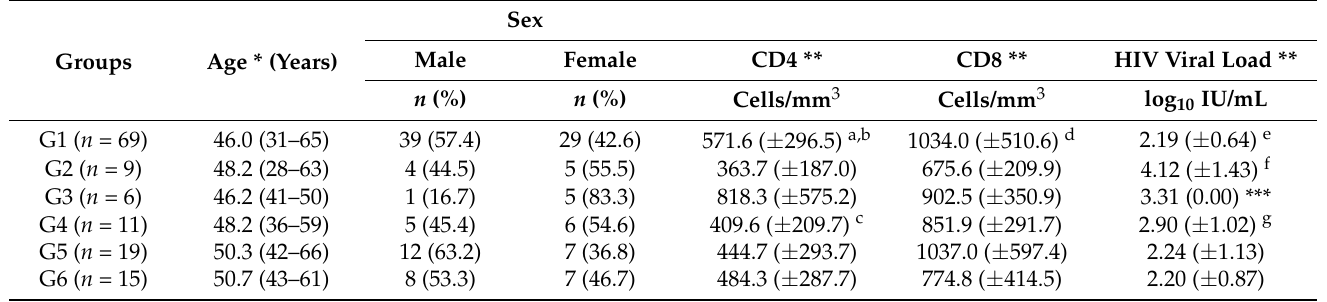
Table 1. Demographic characteristics, CD4 and CD8 T-cells counts, and HIV viral load in patients with HIV infection and HTLV-1, HTLV-2, and/or HCV